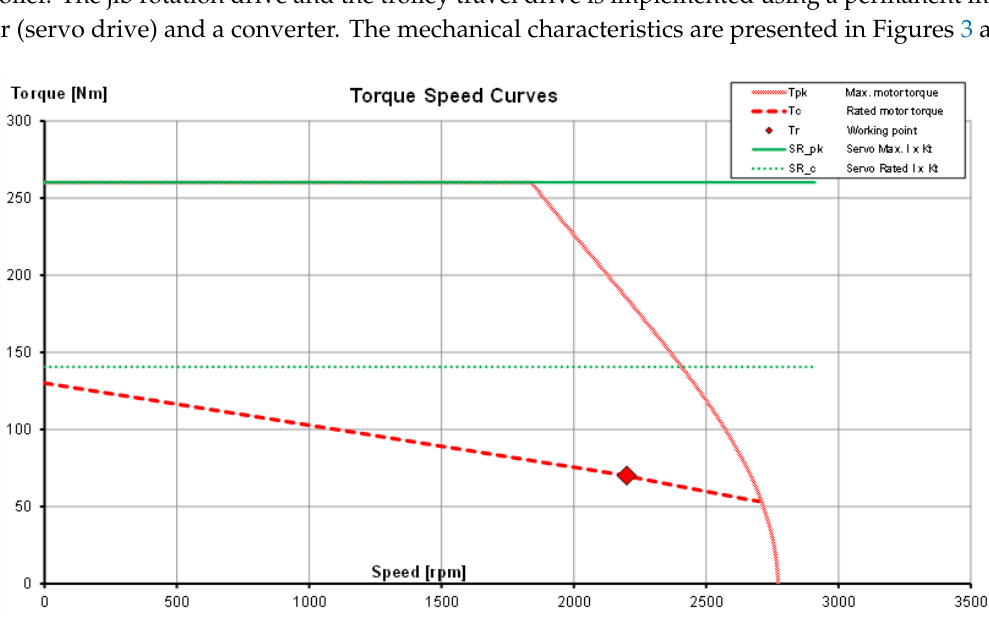
Figure 3. Mechanical characteristics of the hoist-drive motor with the converter (Udc voltage = 560 V), where: Tpk—curve for S5 duty cycle (intermittent operation with a large number of connections and electric braking), Tc—curve for S1 continuous cycle, Tr—drive operating point, SR_pk—torque limit at maximum current, SR_c—torque limit at rated current.